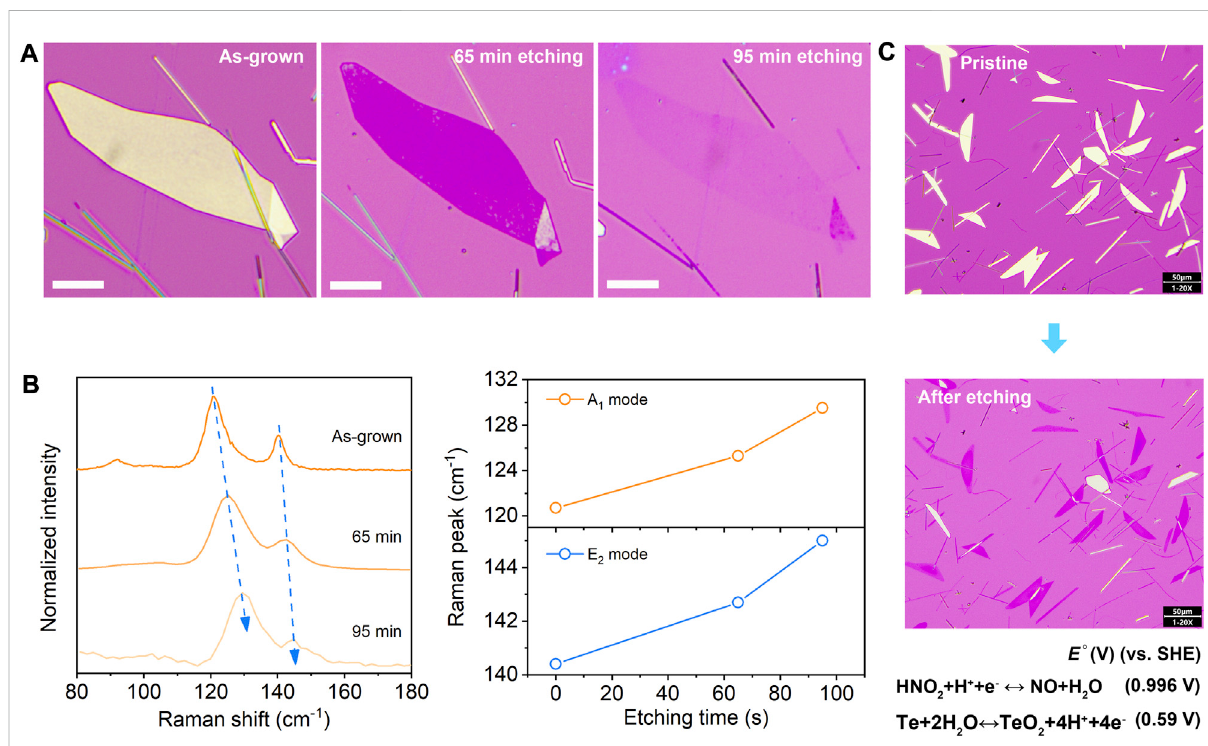
FIGURE 2 ControllablethinningoftheTenanosheets. (A) OpticalimagesofanindividualTe fl akeupon in-situ oxidativeetchingwithHNO 2 solution.Scale bar,10 μ m. (B) CorrespondingRamanspectraoftheTesample,indicatingblueshiftofA 1 andE 2 peakswiththicknessreduction. (C) Opticalimagesof Te before and after the wet etching process with HNO 2 , revealing the capability of scalable